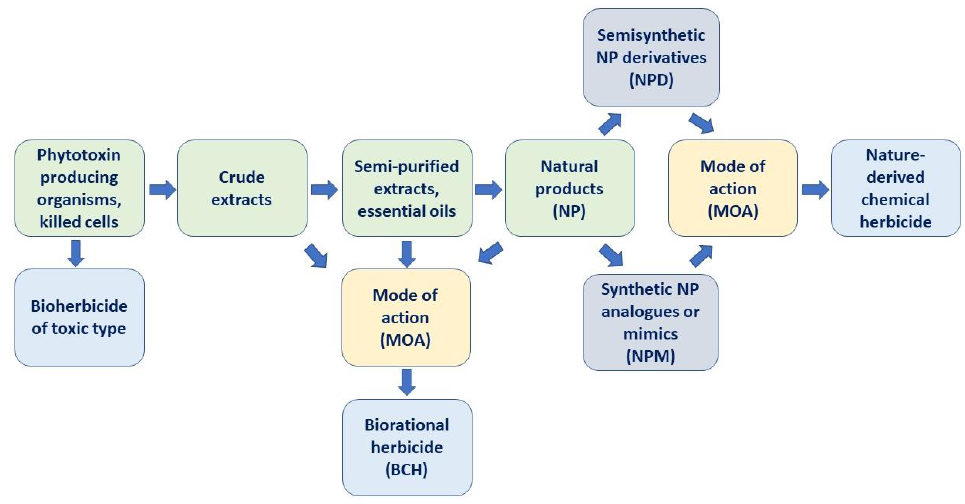
Figure 1. A scheme for the development of herbicides based on natural